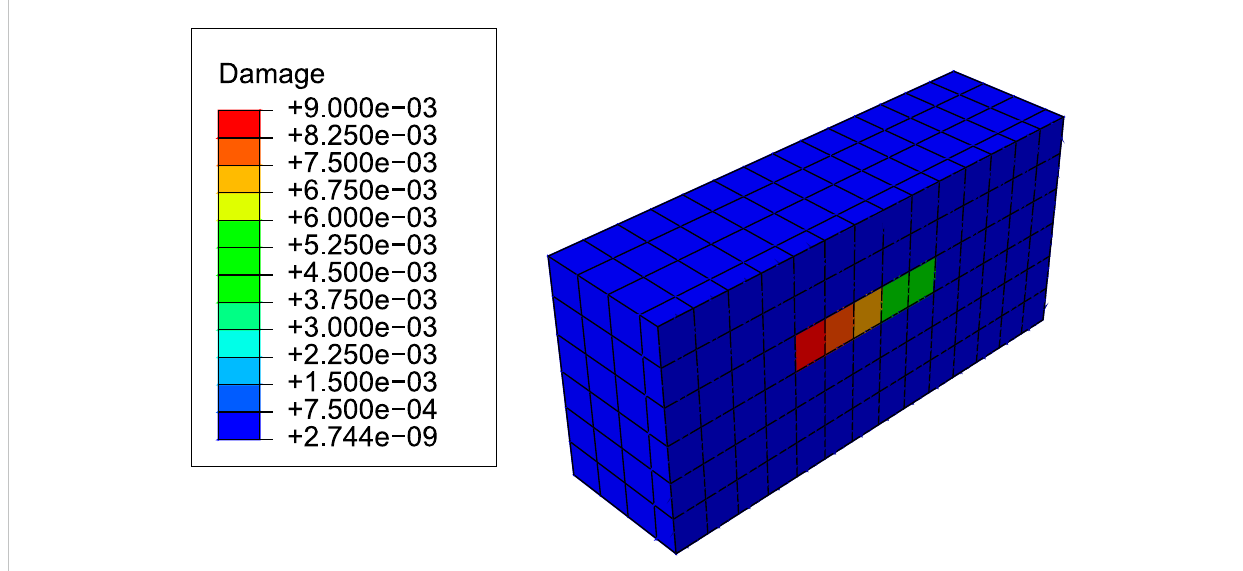
FIGURE 4 Initial damage distribution for the targeted bone remodelling simulations (view cut by a middle plane of the subregion of the model where results were